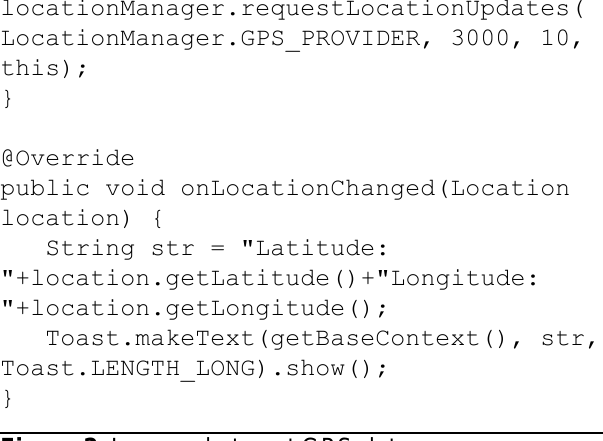
Figure 2. Java code to get GPS